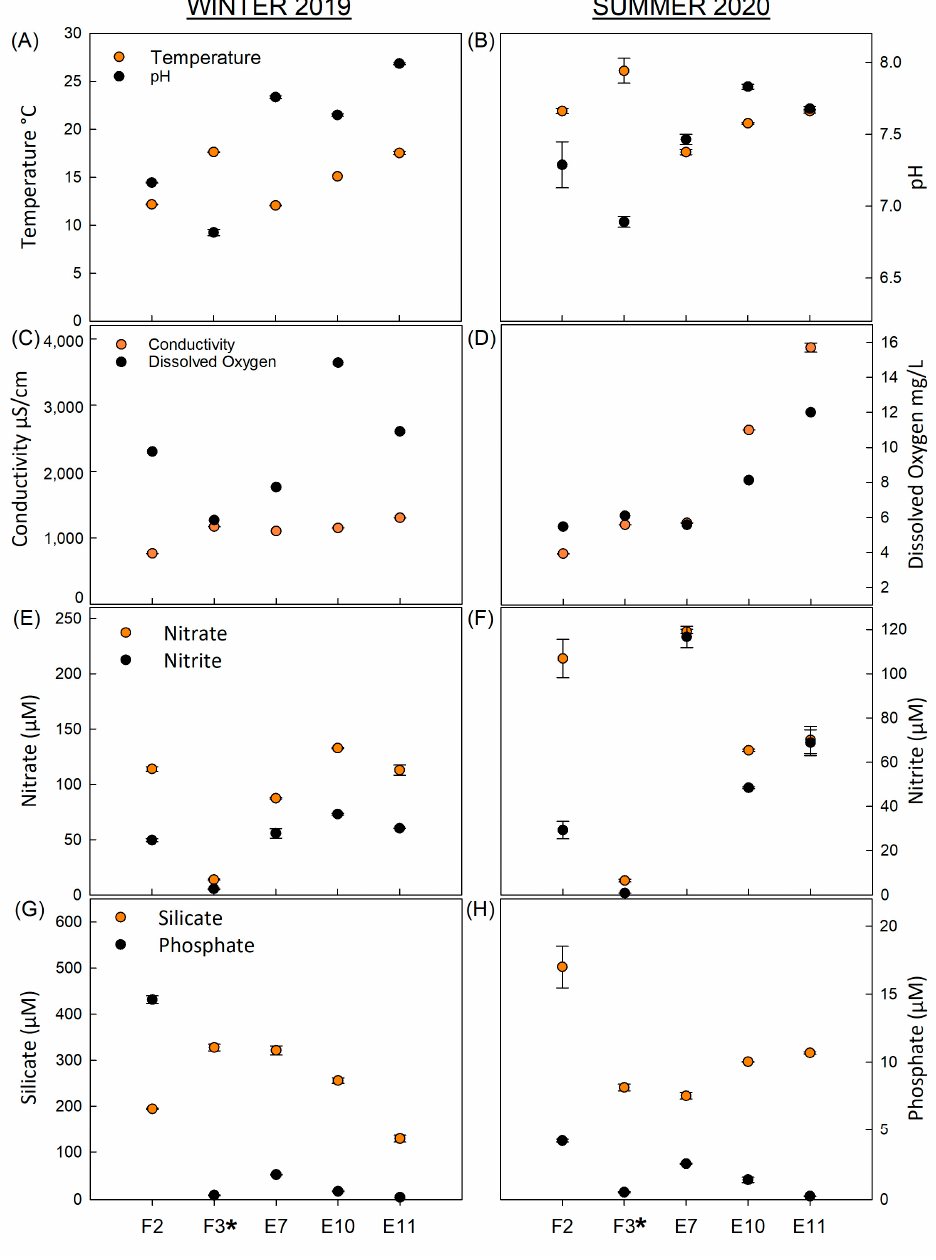
Table 2. Water quality factors in all sampled stations during winter and summer. All bold numbers are values that exceed the maximum allowed limit (MAL). The values in brackets are the results previously reported by Rivera et al. (2020). WINTER